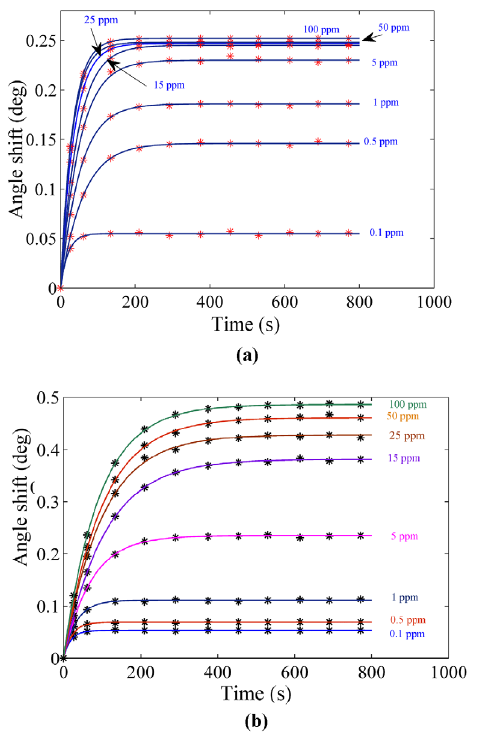
Figure 7. Sensogram for detection of the Pb ion in different concentration: a) PPy sensing layer b) PPy-MWCNTs sensing layer.